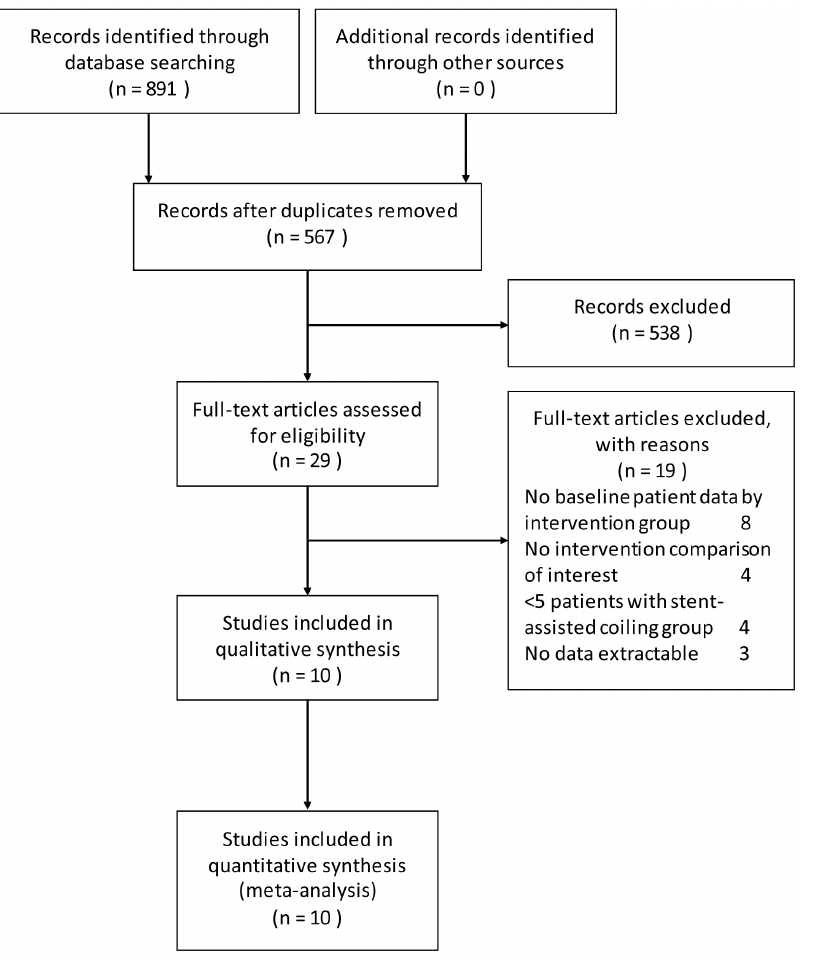
Figure 1. Flowchart of studies to final number of eligible studies.